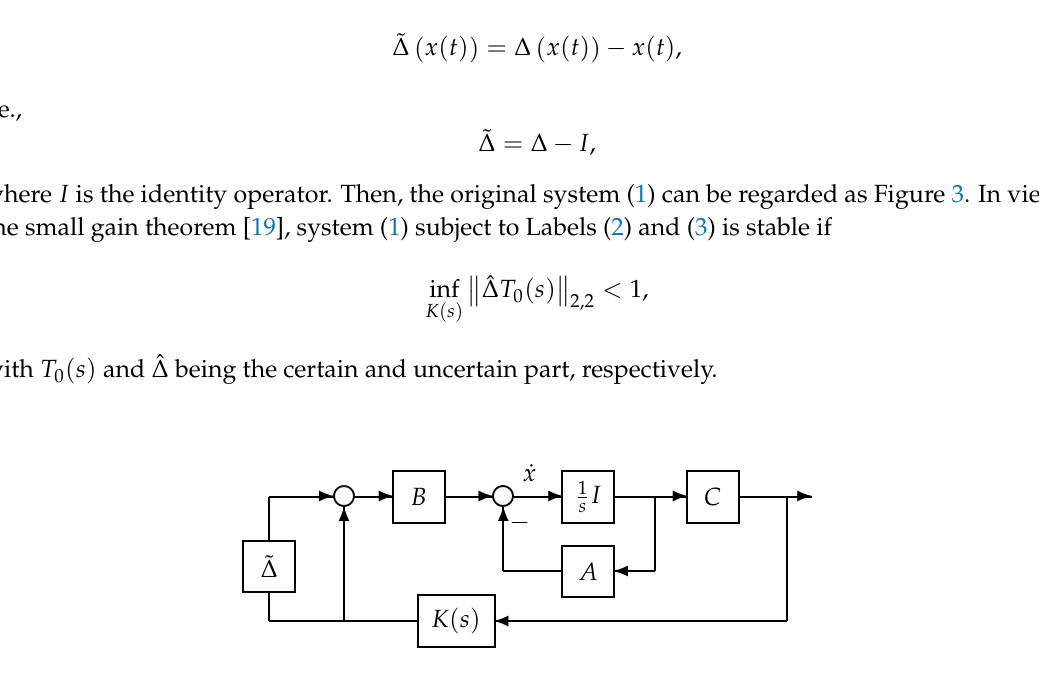
Figure 3. Small gain setup of the feedback control system